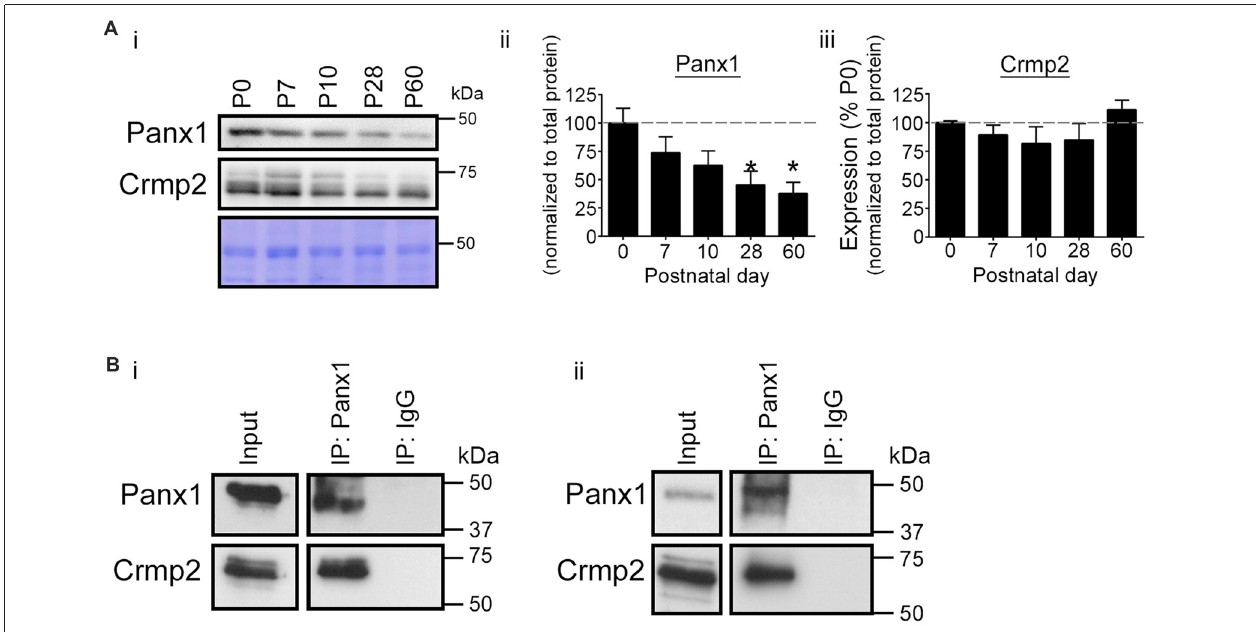
FIGURE 2 | Validation of the Panx1-Crmp2 interaction in the mouse ventricular zone (VZ). (Ai) Western blot of a time course of Panx1 and Crmp2 expression in the VZ. (ii) Panx1 expression peaked within the early postnatal period (P0–P7), and dramatically decreased with age (P28–P60; p = 0.0365 by one-way analyses of variance (ANOVA); F ( 4,10 ) = 3.9; Dunnett’s multiple comparison test post hoc , P28 p = 0.0352, and P60, p = 0.0177; n = 3). Coomassie Blue was employed as a loading control. (iii) Crmp2 expression remained relatively constant across this time course ( F ( 4,10 ) = 1.3; p = 0.3333, one-way ANOVA; n = 3). (B) Western blot of endogenous Panx1 IPs from mouse brain VZ tissue. Crmp2 co-precipitated specifically with Panx1 from young (P10; i ) and adult (P60; ii ) mouse VZ. For the complete blots of part (B) , see Supplementary Material. This data was previously included in the PhD thesis of LWS (link: https://dspace.library.uvic.ca/handle/1828/